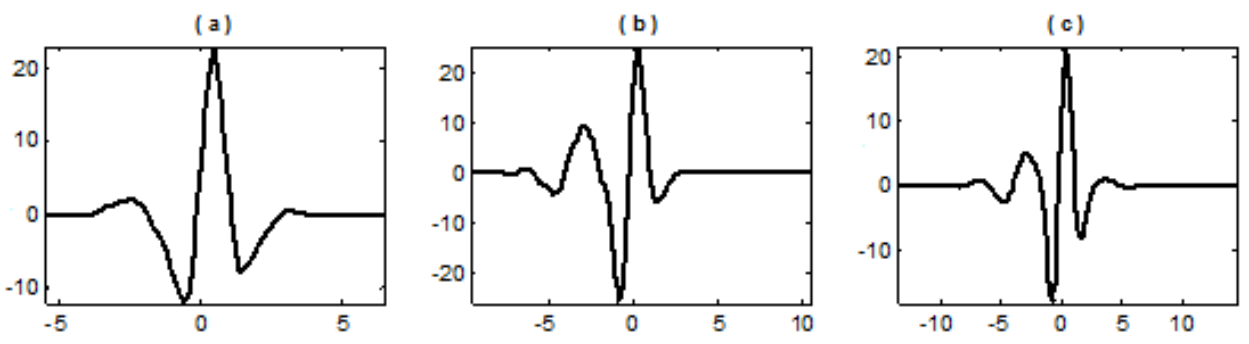
Figure 3. Wavelet constructed with basis function (3) and different selection of ( M , N ): ( a ) when ( M , N ) = (4,3); ( b ) when ( M , N ) = (6,5); ( c ) when( M , N ) =